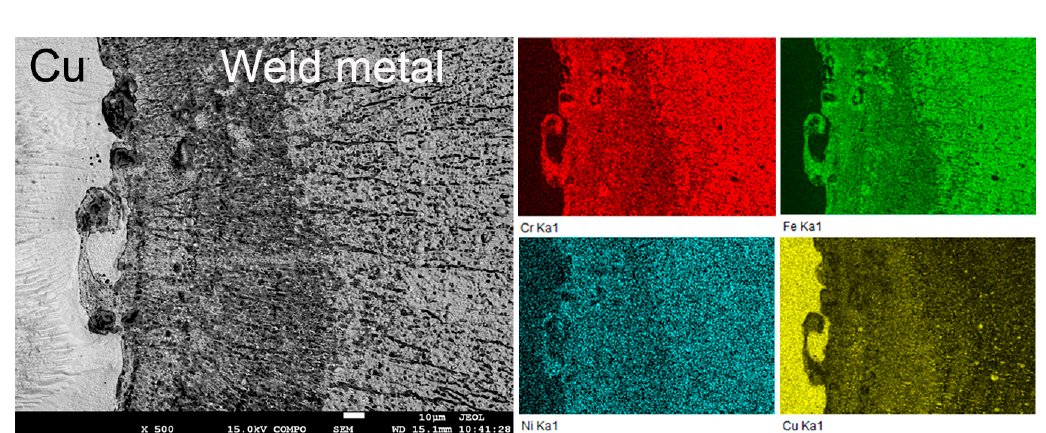
Figure 9. Elemental mapping across copper-weld metal interface (weld No.